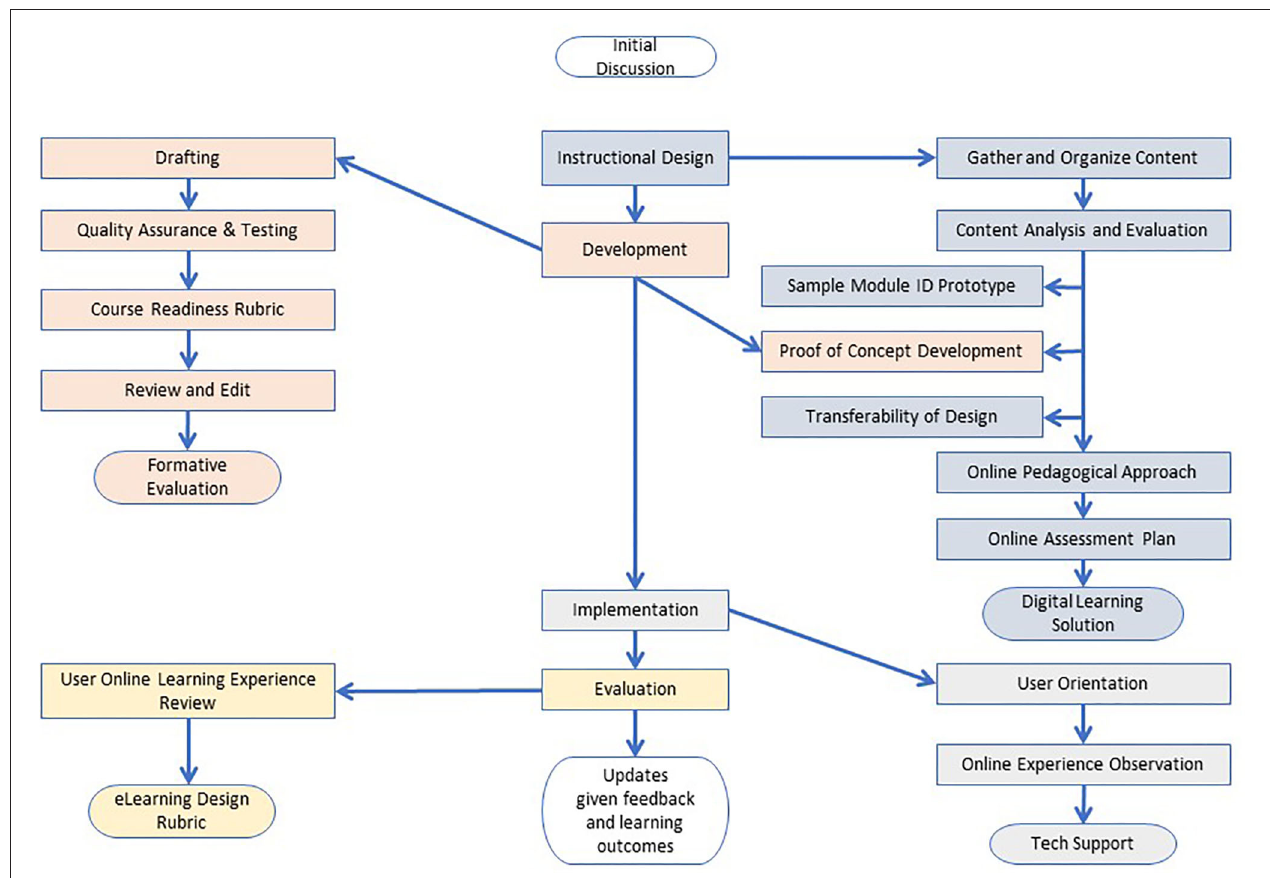
FIGURE 1 | Online HSCHW curriculum transforming